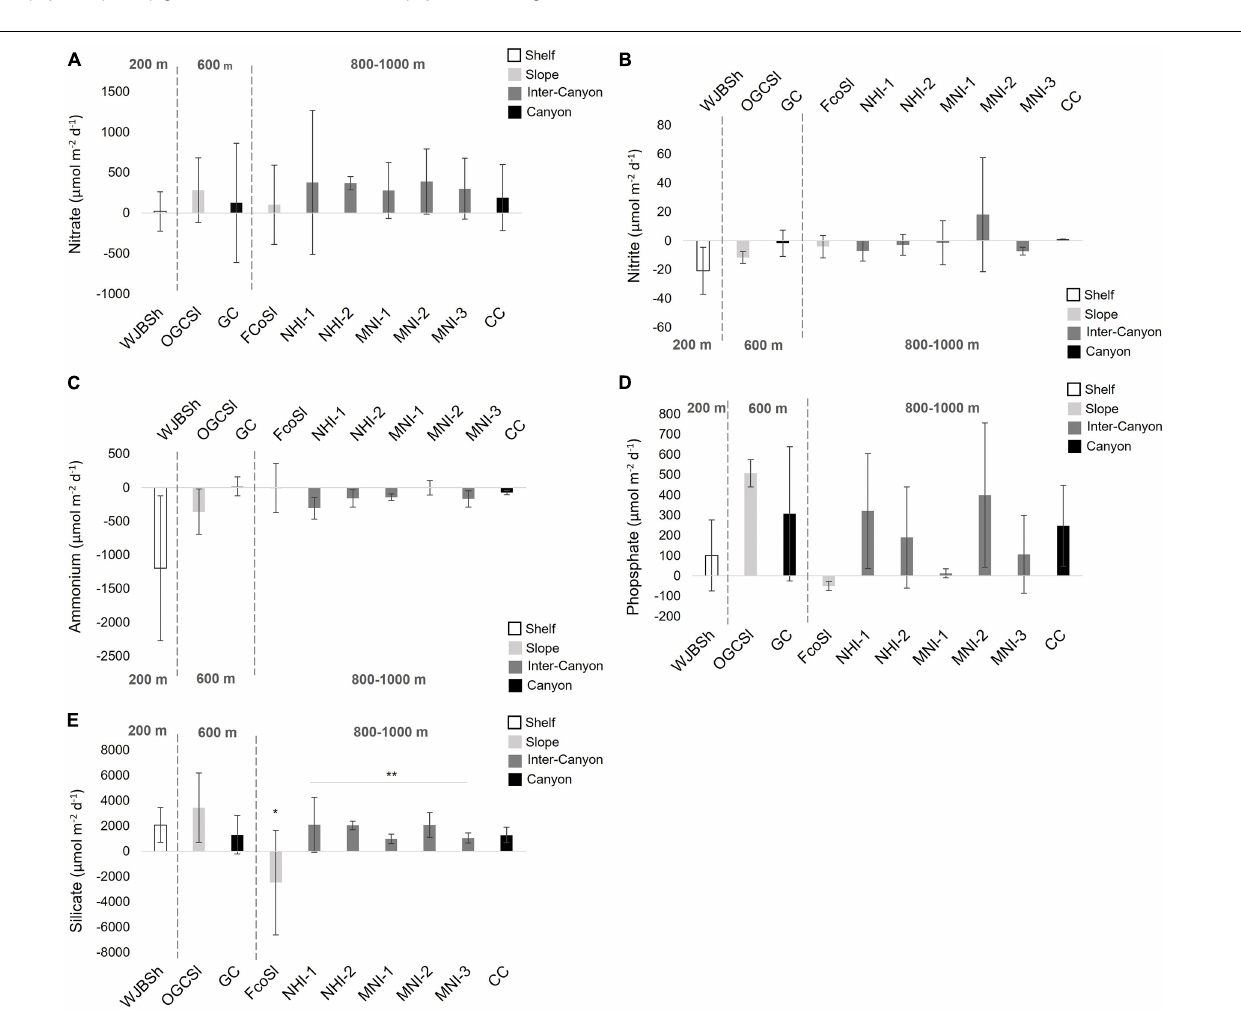
Frontiers in Marine Science |